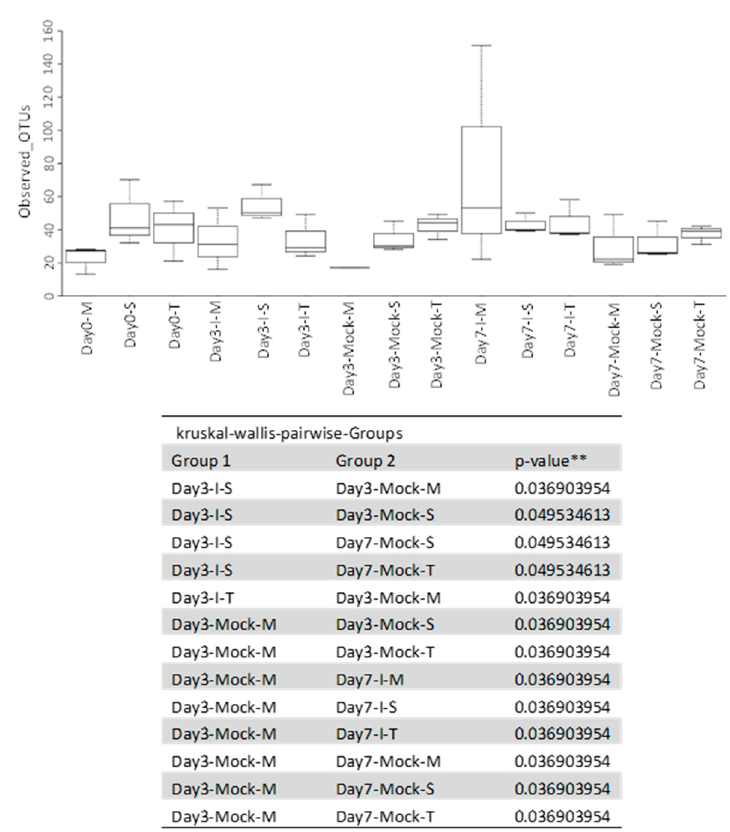
Figure 3. Alpha diversity of samples. Observed OTU boxplot and Kruskal–Wallis pairwise compar- isons (** p < 0.05). The data are mean ± SE of 3 replicates, and each replicate consists of four seeds.